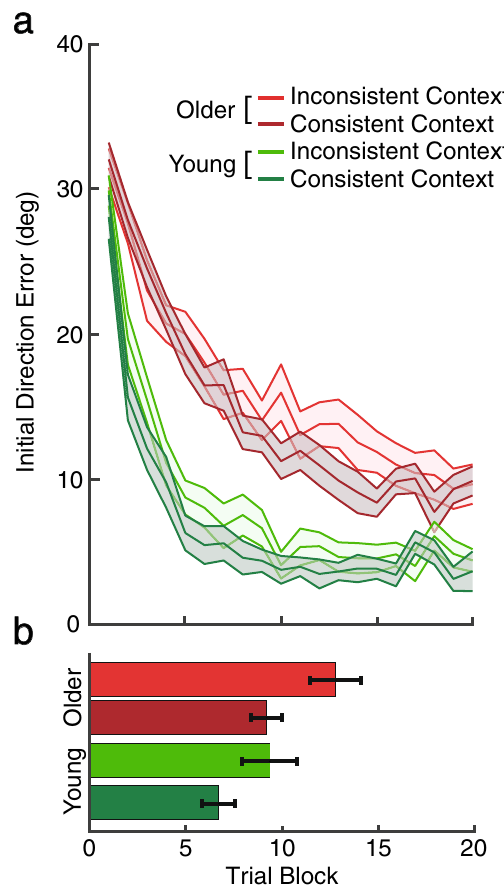
Figure 4. Visuomotor adaptation performance in the re-learning phase. We compare the re-learning performance of young (green) and older (red) adults from the dual-task groups in the learning phase. Within each age cohort, the inconsistent context group, who performed the secondary task in the learning but not in the re-learning phase, and the consistent context group, who continued to perform the secondary task, are indicated by the light and dark colors, respectively. ( a ) Initial direction error in the re-learning phase. ( b ) The number of trial blocks required to reach asymptotic initial direction error during the re-learning phase. Error bars indicate